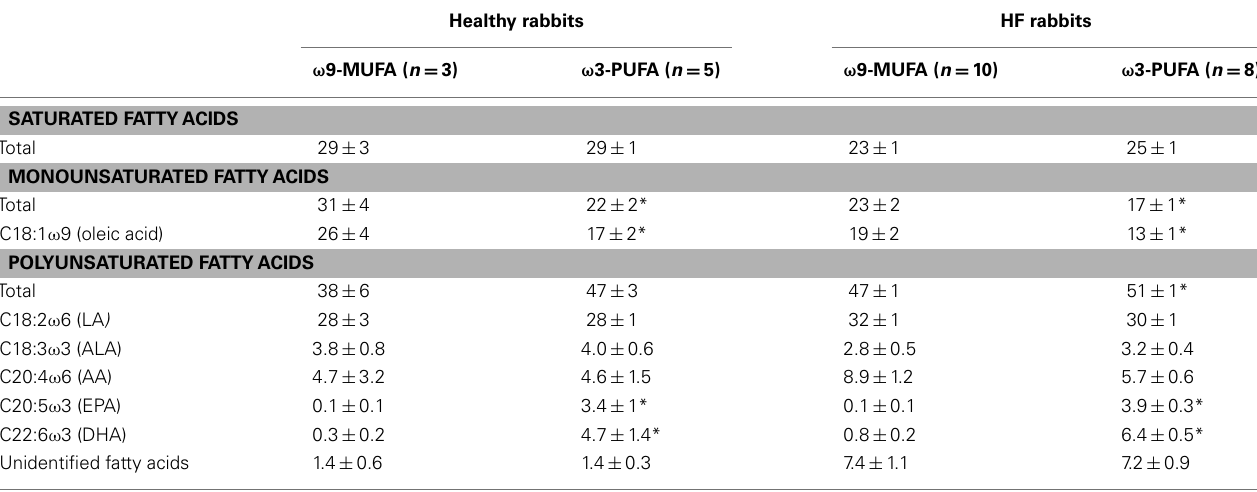
Table 2 | Phospholipid composition of the heart (% of total fat